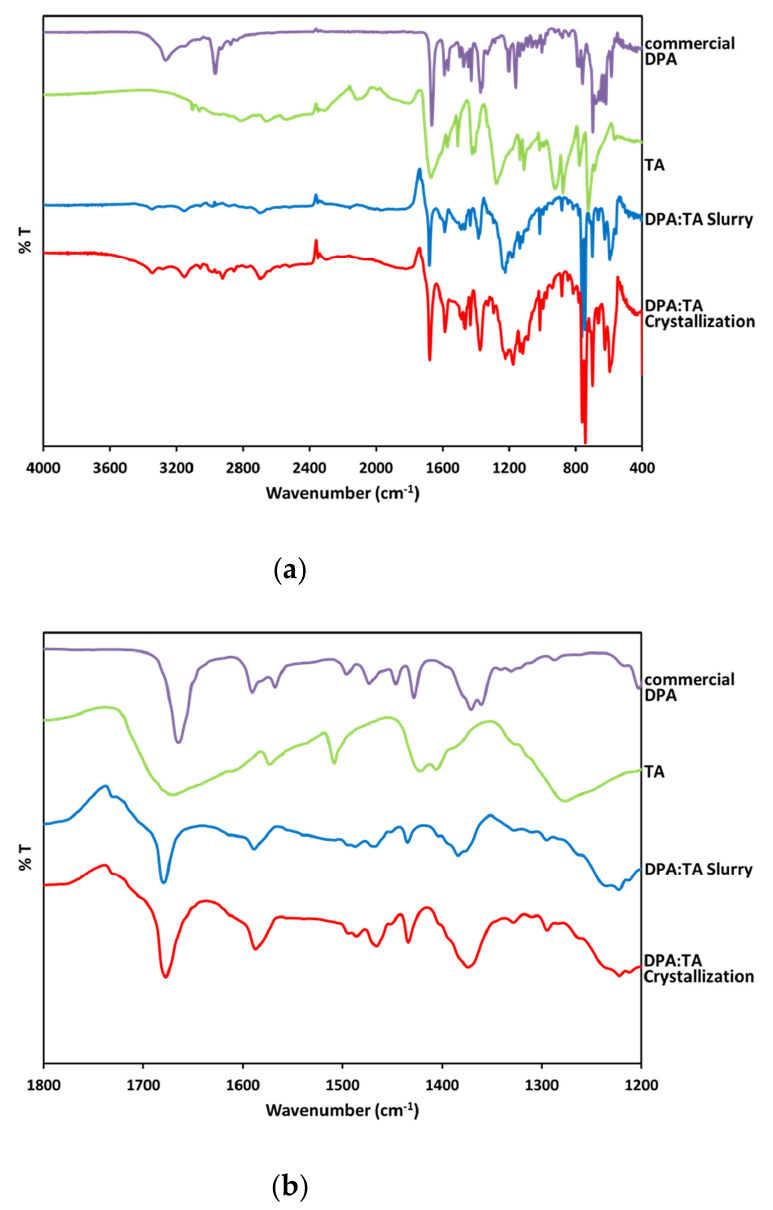
Figure 8. FT-IR spectra, (a) 4000-400 cm -1 and (b) 1800-1200 cm -1 , of commercial DPA, TA, DPA:TA salt obtained from slurry method and DPA:TA salt obtained slow evaporation method.